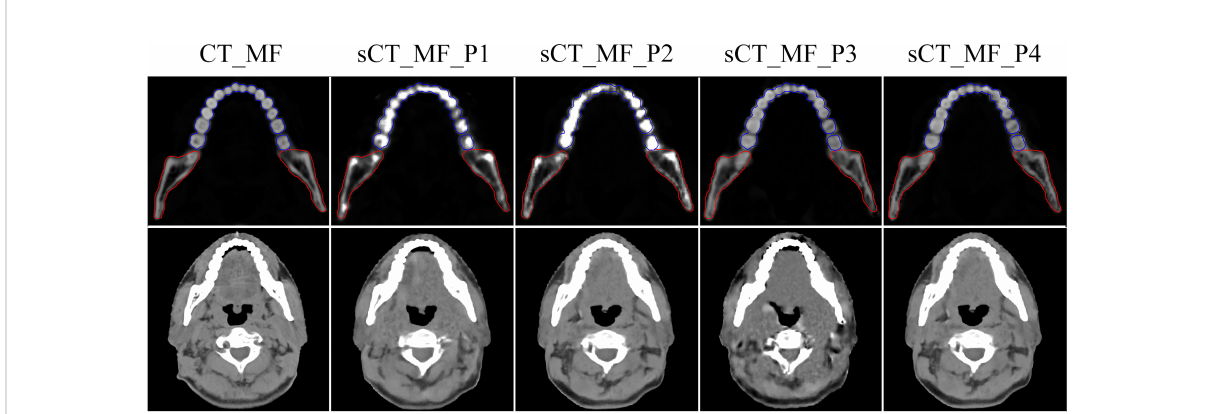
FIGURE 2 Visualized differences of CT_MF and sCT_MF images with different preprocessing methods. The display windows for the fi rst and second rows were [0, 3000] HU and [-360, 440] HU, respectively. Blue lines represent the contour of the teeth, and red lines represent the contour of the mandible. The images in the fi rst to fi fth columns were CT_MF, sCT_MF_P1, sCT_MF_P2, sCT_MF_P3 and sCT_MF_P4, respectively. Different image preprocessing methods have their own advantages in different CT number ranges, and sCT_MF_P4 performs